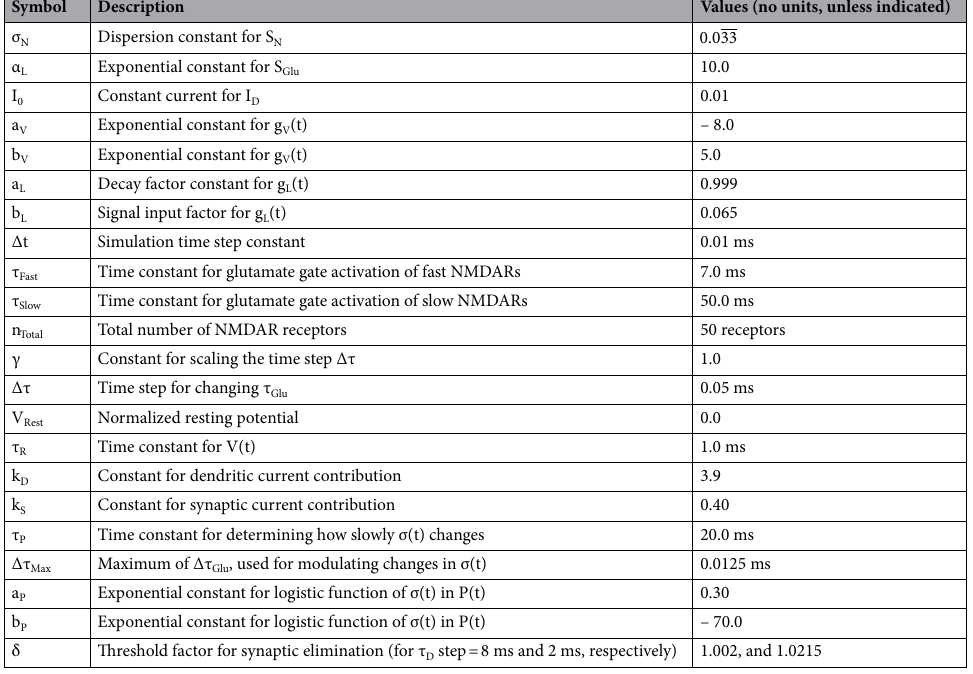
Table 1. SITDL model